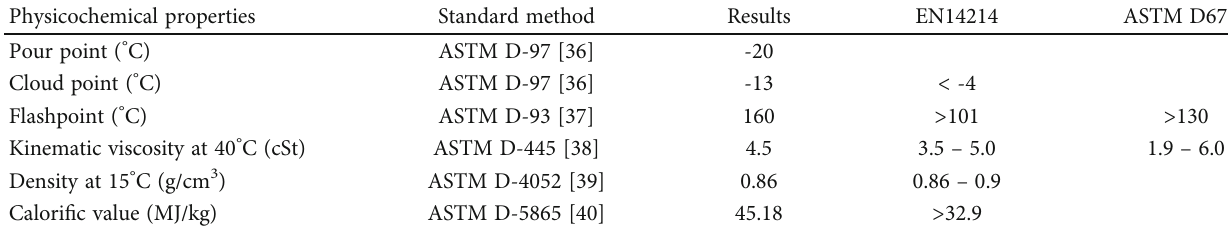
Table 8: Physicochemical properties.